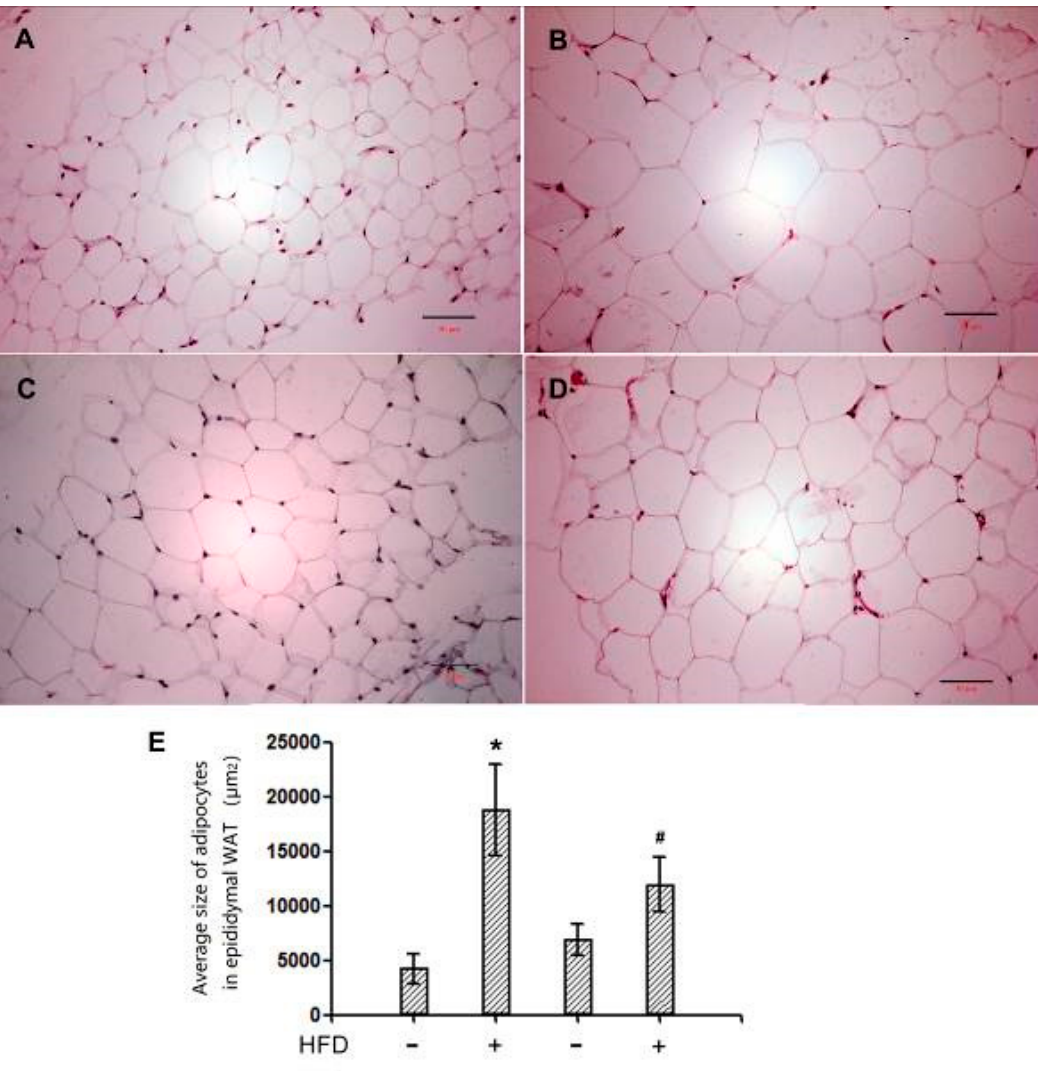
Figure 2. Hematoxylin and eosin staining of EWAT. EWAT tissues were fixed in 4% paraformaldehyde for 24 h, and then histologically processed and sectioned at thickness of 6 um. Hematoxylin and eosin staining was performed following manufacturer’s instructions. Quantification was performed with ImageJ. Three samples from three independent animals were assessed per group. Error bars represent standard derivation. Scale bars represent 50 um. ( A ): Representative hematoxylin and eosin staining picture of EWAT from control animals. ( B ): Representative hematoxylin and eosin staining picture of EWAT from HFD-treated animals. ( C ): Representative hematoxylin and eosin staining picture of EWAT from HBO-treated animals. ( D ): Representative hematoxylin and eosin staining picture of EWAT from HFD + HBO-treated animals. ( E ): Quantification of the adipocyte areas. *: statistically di ff erent from control group animals ( p < 0.05). #: statistically di ff erent from HFD group animals ( p <